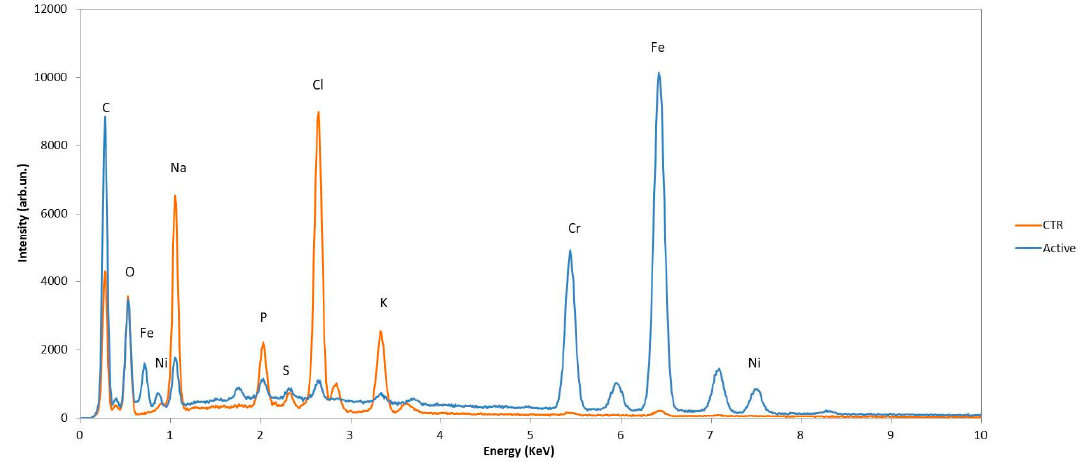
Figure 9. Plotted spectra of the control disk and the active-treated disk. Table 1. Atom % of sulfur on the control disk and on the disk with the active.